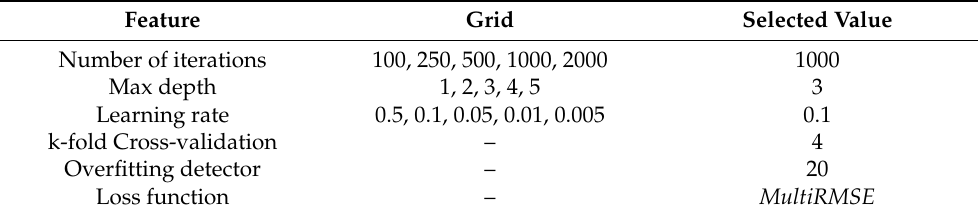
Table 4. Grid search